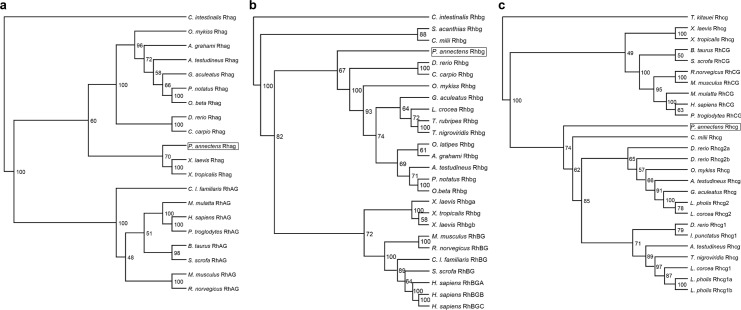
Dendrograms of (a) Rhesus blood group-associated glycoprotein (Rhag/RhAG), (b) Rhesus family B glycoprotein (Rhbg/RhBG) and (c) Rhesus family C glycoprotein (Rhcg/RhCG) including those of Protopterus annectens. Numbers presented at each branch point represent bootstrap values from 100 replicates. Ciona intestinalis Rhag and Rhbg and Thelohanellus kitauei Rhcg are used as outgroups for their respective dendrogram.